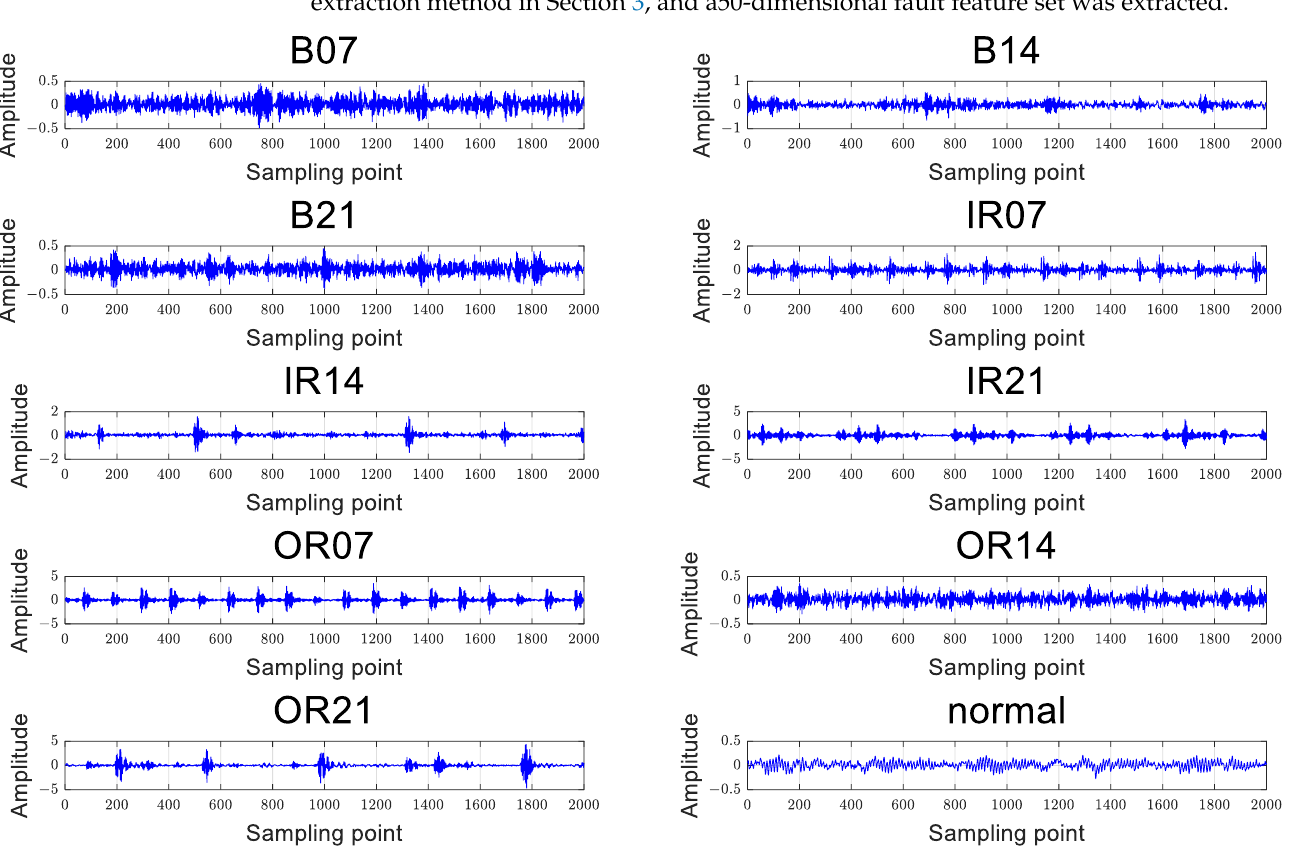
Figure 9 shows the time domain waveforms of the motor vibration signals under 10 bearing conditions. It can be seen from the diagram that it is difficult to distinguish fault types using only vibration signals. Therefore, the signal was analyzed using the feature extraction method in Section 3, and a50-dimensional fault feature set was extracted.